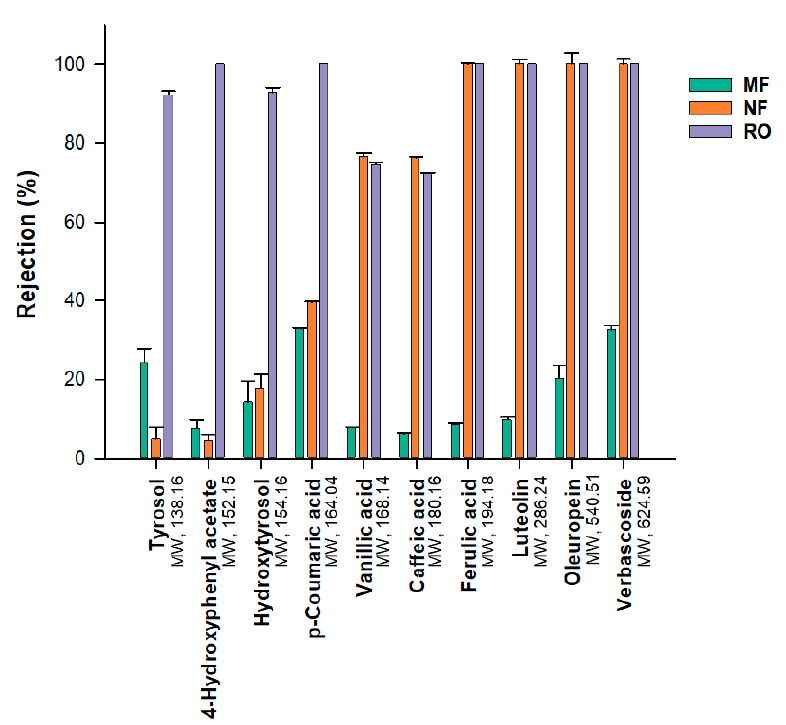
Figure 5. Rejection of microfiltration (MF), nanofiltration (NF) and reverse osmosis (RO) membranes towards phenolic compounds. Table 2. Hypoglycaemic and hypolipidemic activity [IC 50 value ( μ g/mL)] .